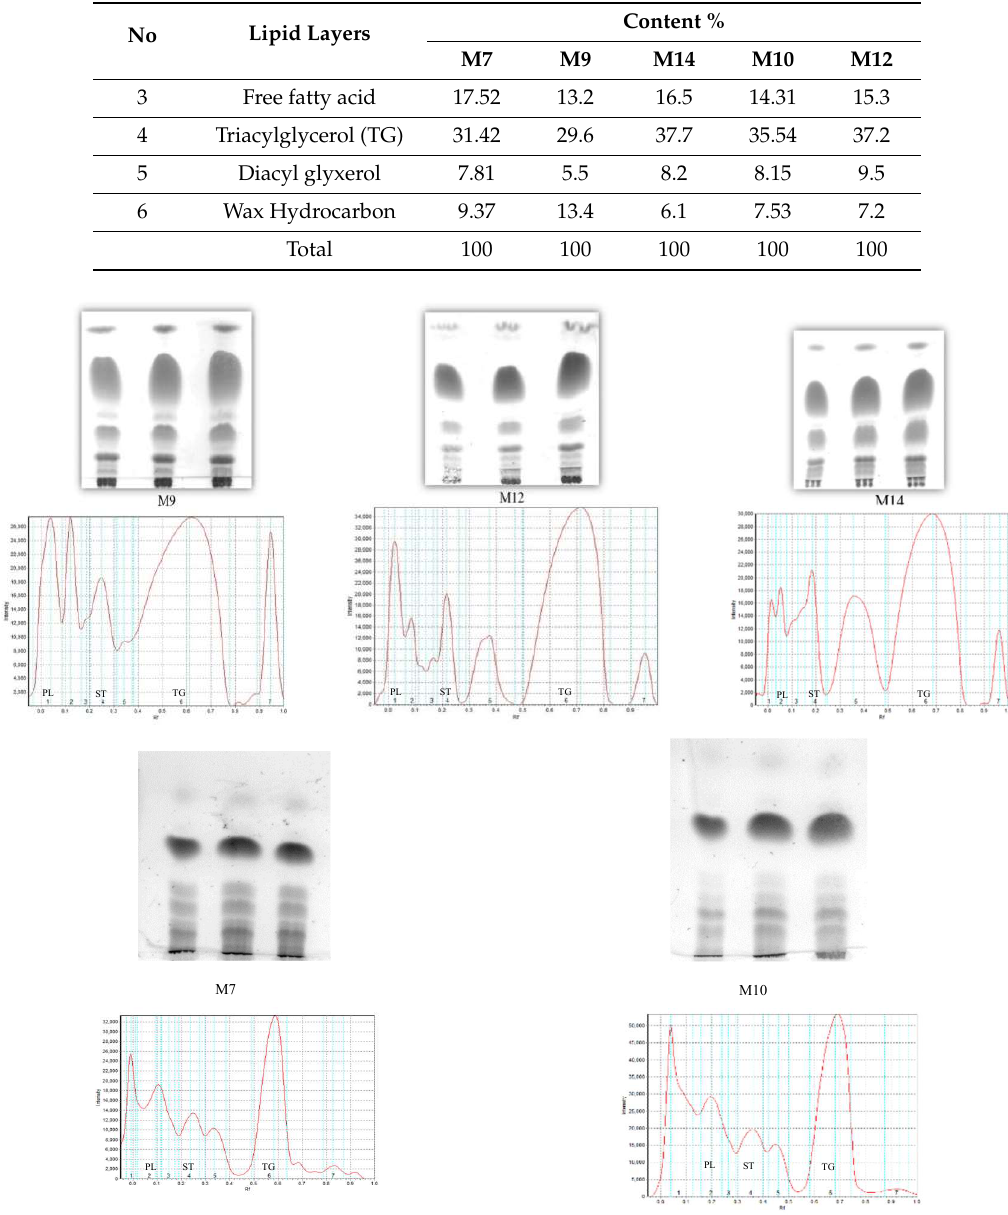
Figure 1. Thin layer chromatography (TLC) images and chromatograms of content of lipid layers of bean seeds. Polar Lipid (PL), Sterol (ST), Triacylglycerol (TG). Table 5. Lipid class composition (% of total lipid).